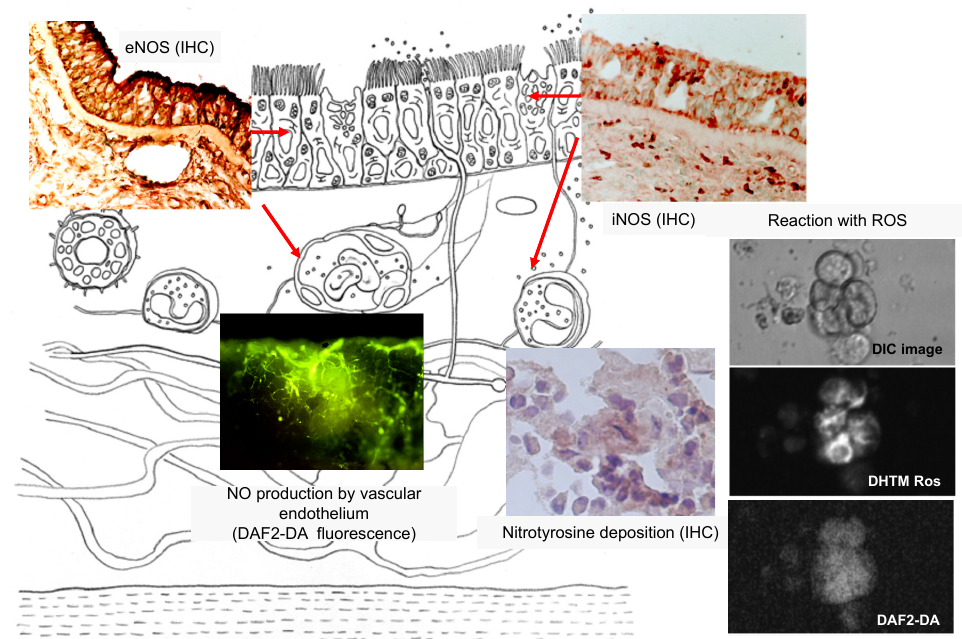
Figure 1. Expression and distribution of different NOS isoforms in human sinonasal mucosa. NOS: nitric oxide synthase, ROS: reactive oxygen species, IHC: immunohistochemistry, DHTM: Ros-dihydrotetramethylrosamine, DAF2-DA: 4,5-diaminofluoresceindiacetate.